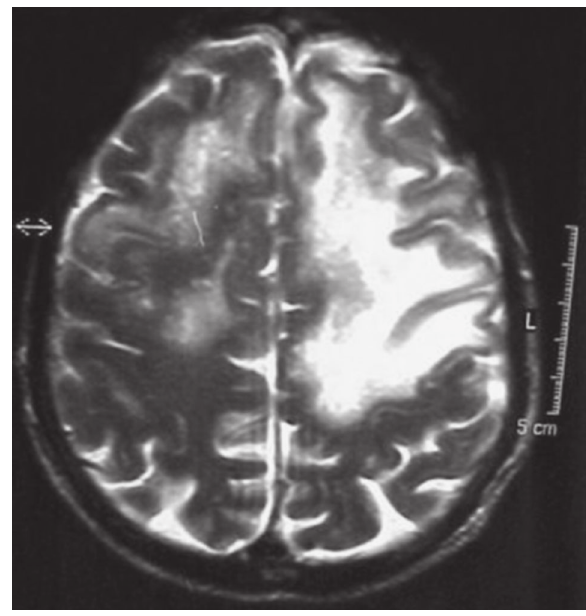
Figure 3. Case 3 – RM (T2 axial) showing mul tiple confl uent white matter lesions, mainly on the left, reaching “U” fi